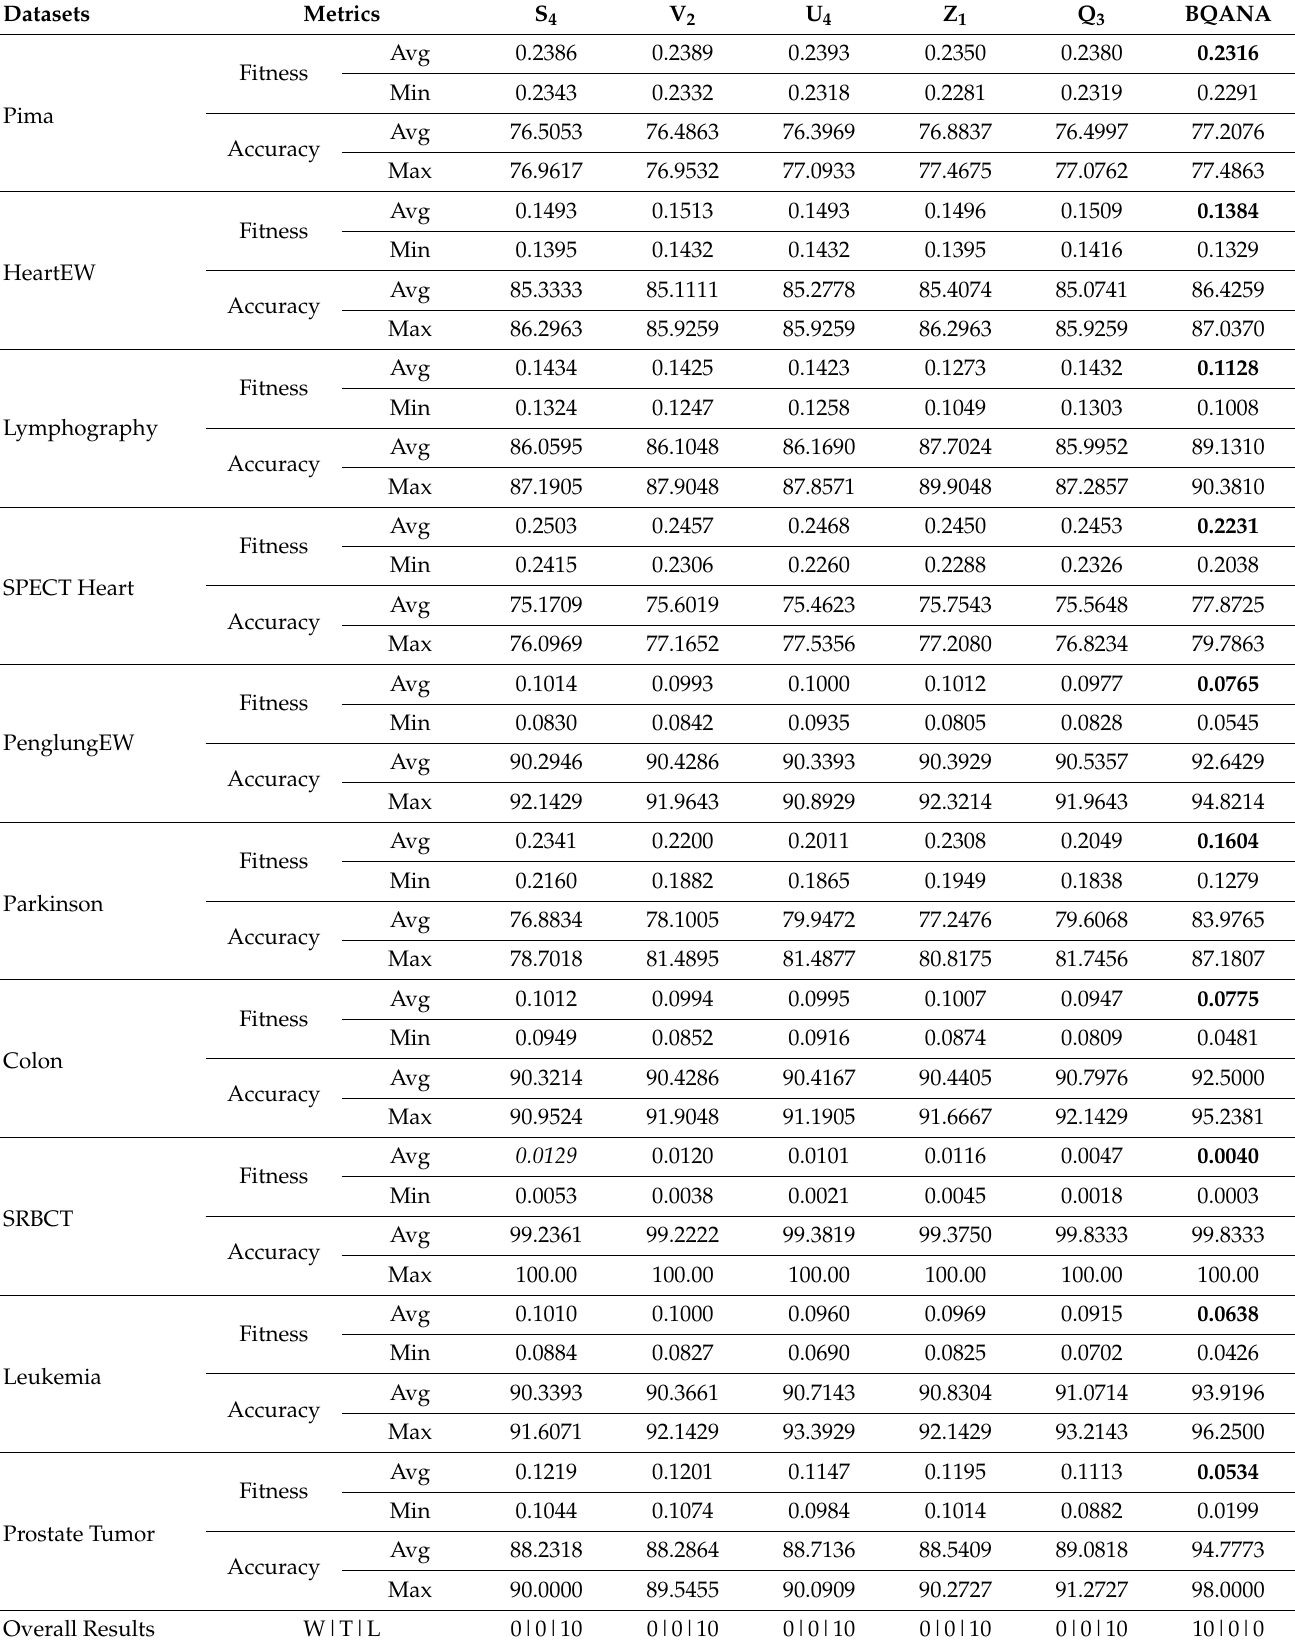
Table 5. The comparison between the BQANA and winners of each